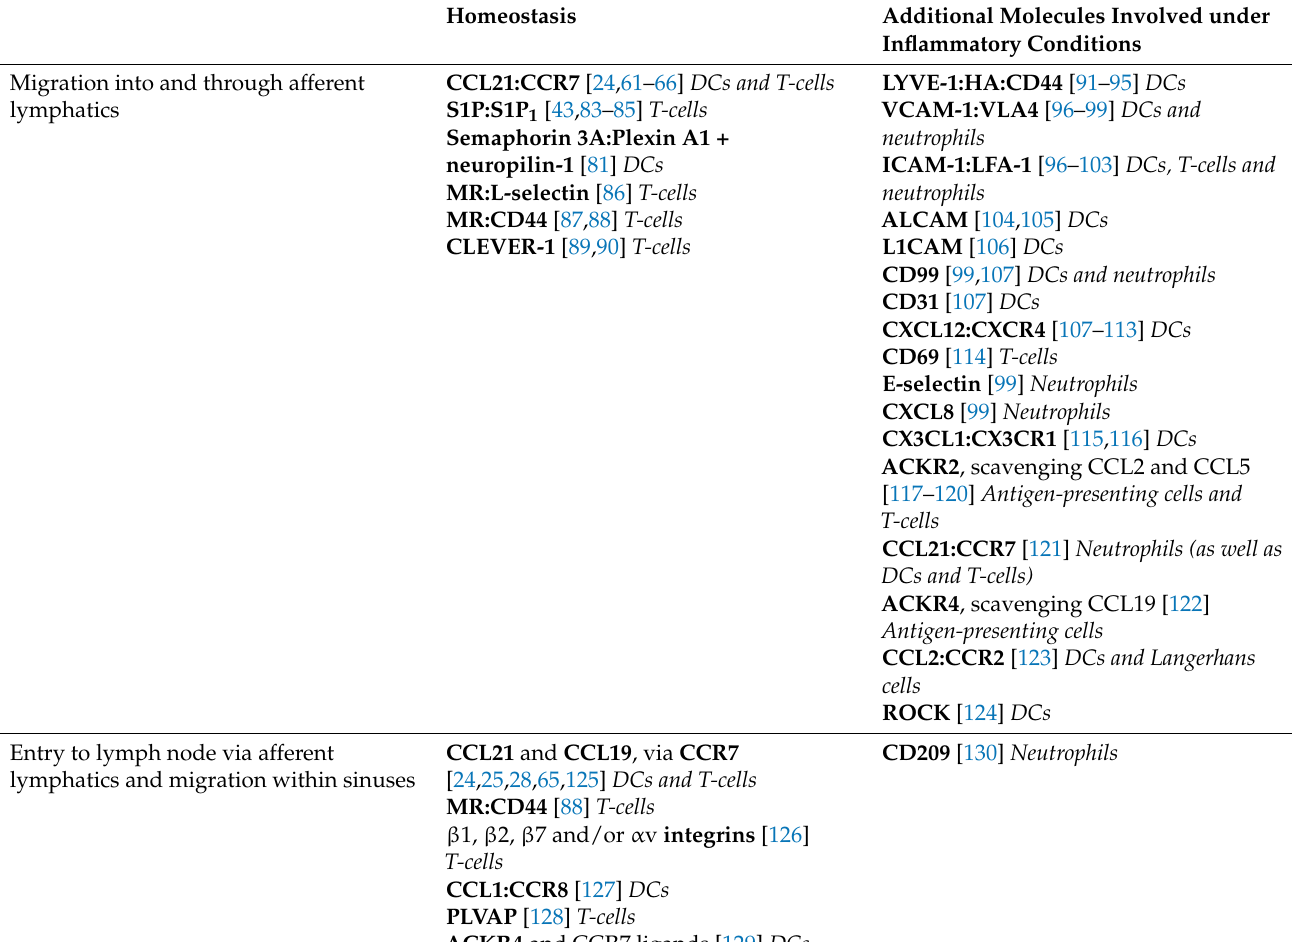
Table 1. Summary of the molecules known to be involved in lymphatic trafficking of leukocytes. Homeostasis Additional Molecules Involved under Inflammatory